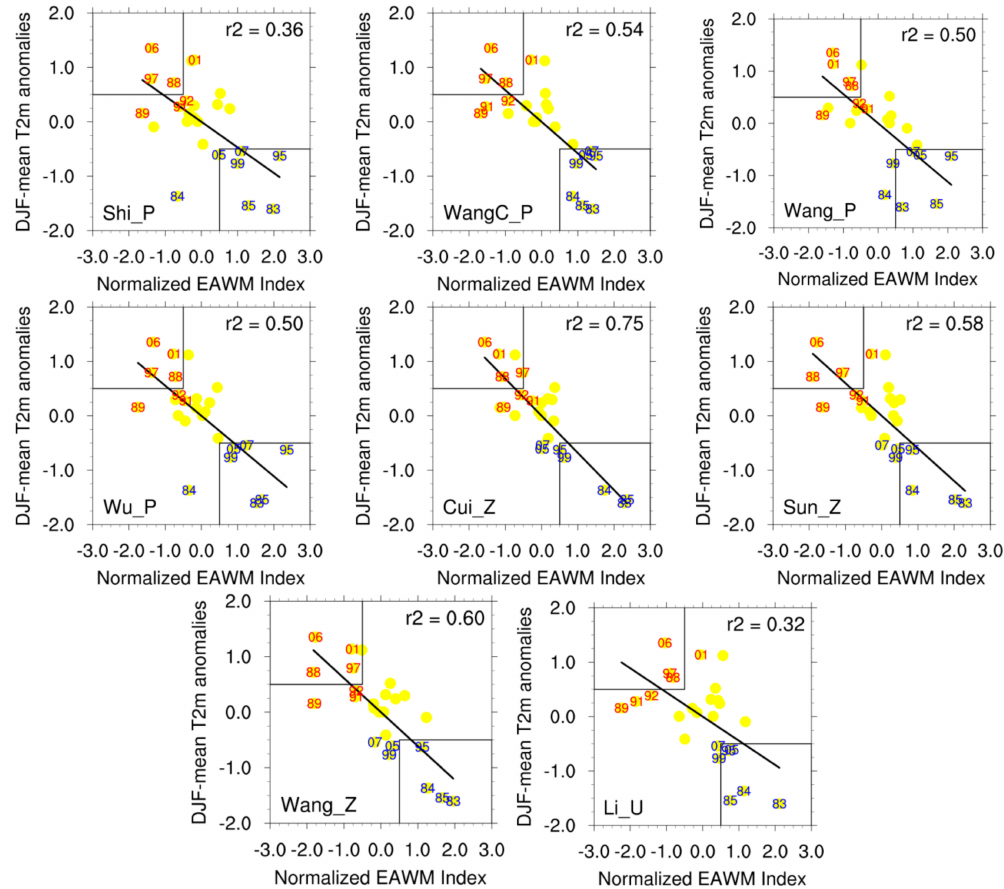
Figure 3. Scatter plots of the normalized EAWM index vs. DJF-mean surface temperature anomalies averaged over East Asia (100–145 ◦ E, 20–50 ◦ N) for the period 1983–2007 based on the EAWM index defined in 11 papers listed in the references. The abscissa (ordinate) of each dot in each diagram represents the amplitude and sign of the EAWM index (the temperature index) for an individual winter season. The “R-squared” in the upper right corner of each plot explain the proportion of variance in temperature. The strong (weak) EAWM year with cold (warm) winter defined in Section 2.2 is shown at the lower right (left) corner with blue (red) characters of each